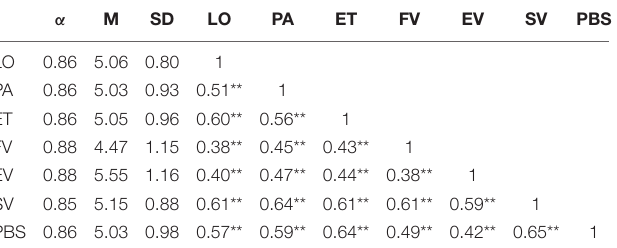
TABLE 4 | Cronbach’s alpha values and